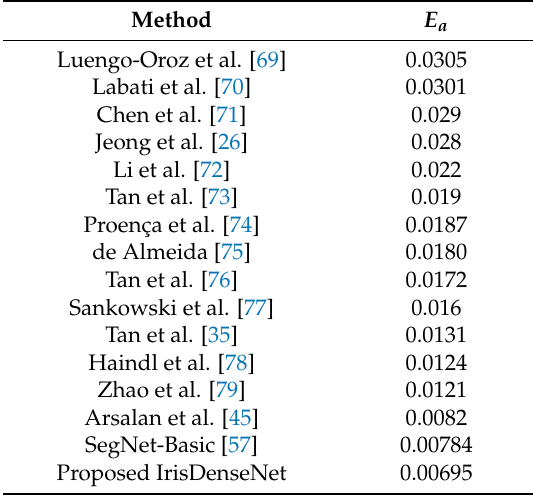
Table 4. Comparisons of the proposed method with previous methods using NICE-II dataset.